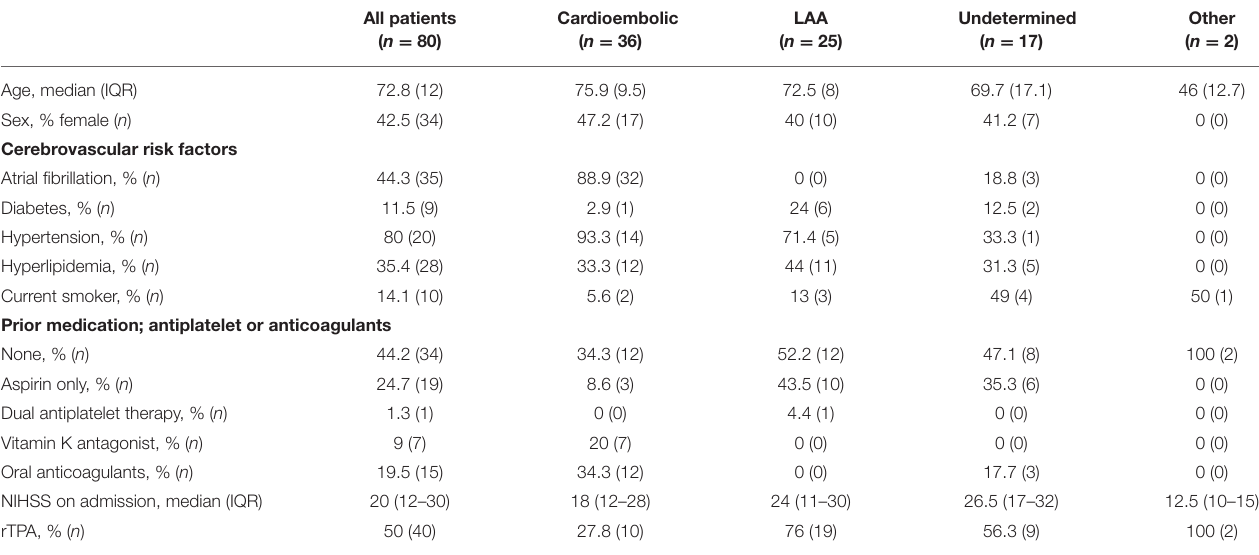
TABLE 1 | Baseline demographics and clinical parameters.